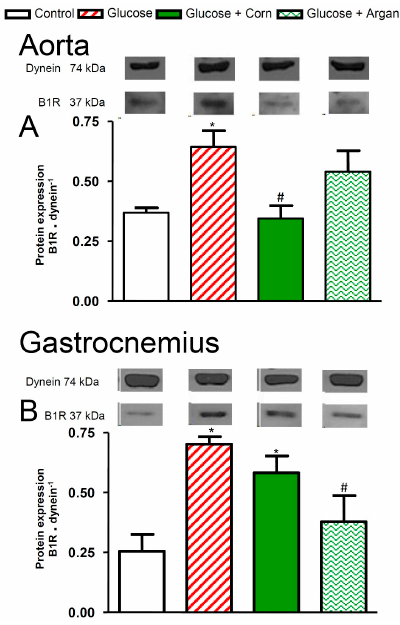
Figure 7. Effects of 12 weeks of glucose feeding combined or not with orally and daily administered (5 mL·kg − 1 ) corn oil or argan oil on ( A ) kinin B 1 receptor protein levels in thoracic aorta expressed in B 1 R·dynein − 1 and ( B ) kinin B 1 receptor protein levels in gastrocnemius muscle expressed in B 1 R·dynein − 1 . Values are the mean ± SEM of five rats per group.* p < 0.05 vs. control, # p < 0.05 vs. glucose.